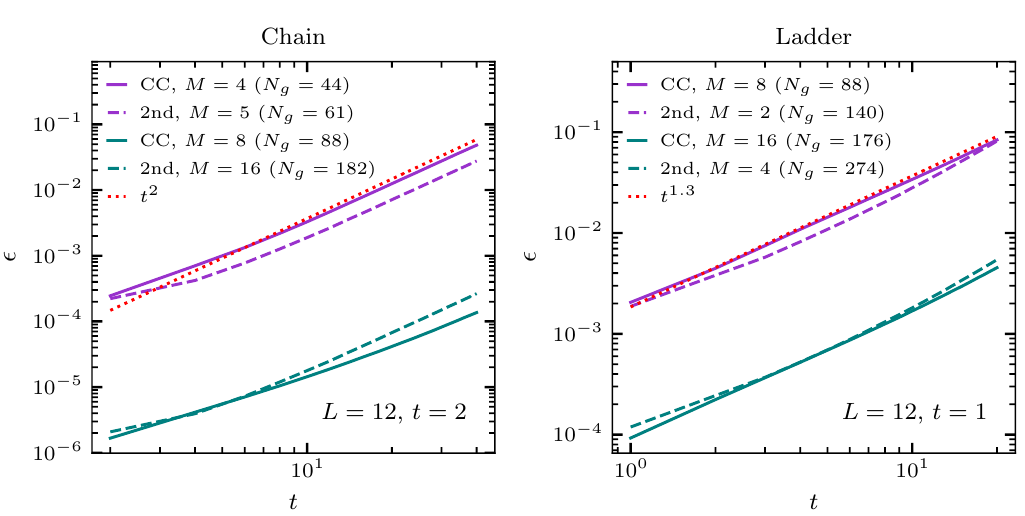
Figure 6: The infidelity ε versus stacking time t for the time evolution operator of the L = 12 Heisenberg model on a chain at t = 2 (left panels) and ladder at t = 1 (right panels), for compressed and second-order circuits that are stacked twenty times. The circuits were chosen such they have similar ε at the optimized t , with M = 4,8 and M = 5,16 for compressed and second-order Trotter circuits on the chain, and M = 8,16 and M = 2,4 for the ladder. As a result the compressed circuits have significantly lower gate count than the corresponding Trotter circuits. The red dashed lines are for the power laws ε ∝ t n with the best fitting power n